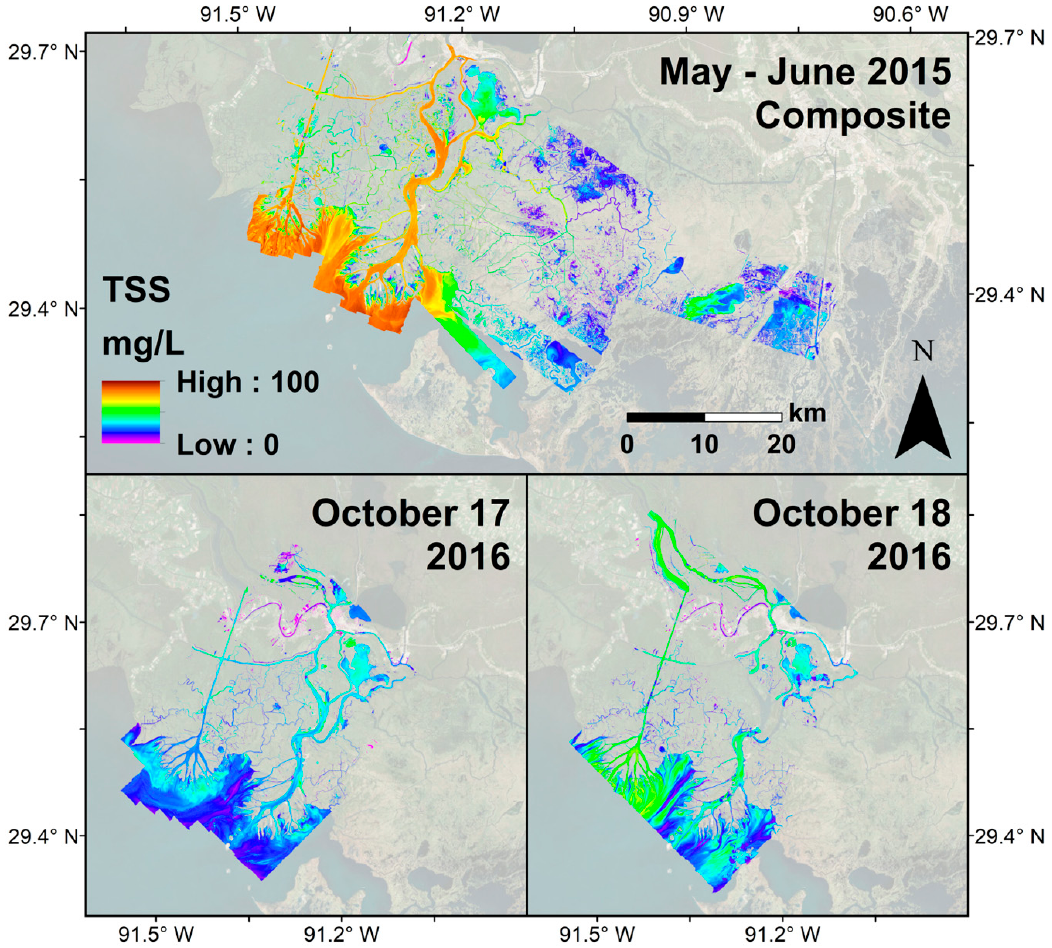
Figure 7. Total suspended solids (TSS, mg / L) maps produced with the modified derivative-based PLSR Figure 7 . Total suspended solids (TSS, mg/L) maps produced with the modified derivative ‐ based algorithm applied to the 2015 and 2016 AVIRIS-NG mosaics. Remote Sens. 2019 , 11 , x FOR PEER REVIEW PLSR algorithm applied to the 2015 and 2016 AVIRIS ‐ NG mosaics.